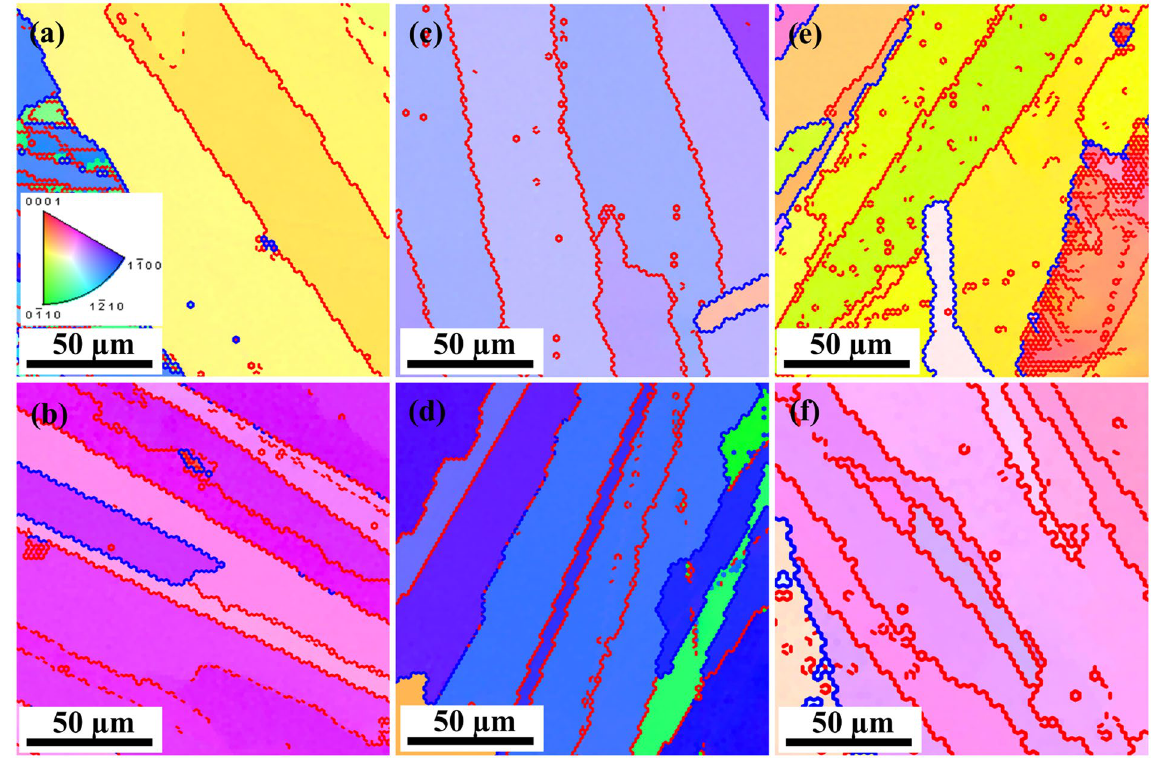
Figure 7. EBSD inverse pole figure maps covered with misorientation lines for grain boundaries. The red and blue lines represent the misorientation angles between 2°~15° (LAGB) and 15°~180° (high-angle GB), respectively. All the panels share the same legend of orientation map. ( a ) Bi 2 Te 2.7 Se 0.3 -A; ( b ) Bi 2 Te 2.7 Se 0.3 -B; ( c )